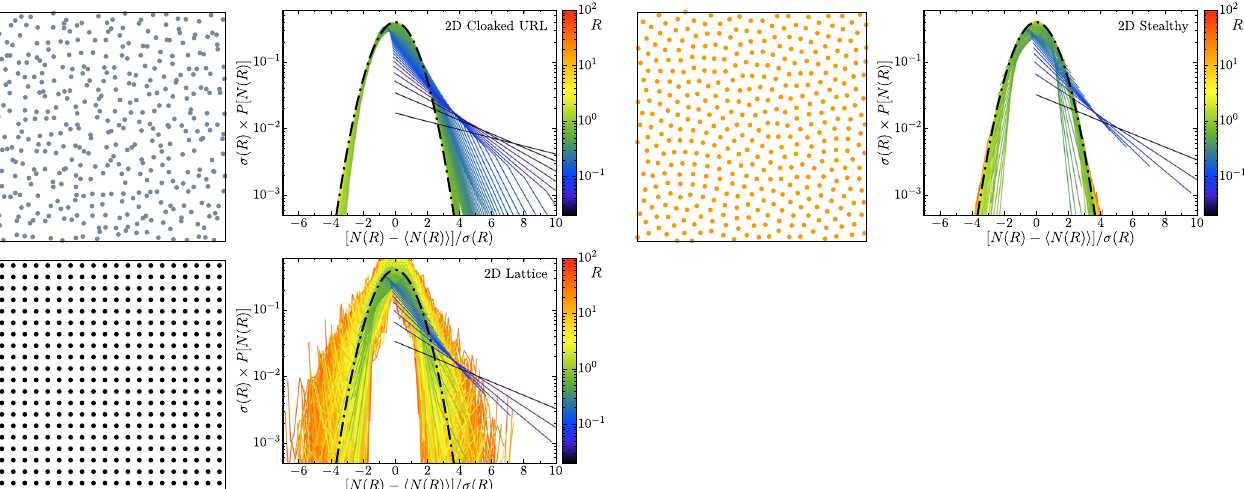
FIG. 4. Representative images of configurations of each of the three 2D hyperuniform models and their corresponding standardized probability distributions, where the deepest blue color (darkest shade) corresponds to zero radius and the deep orange color corresponds to the largest considered radius. The color code reveals differences between the results in this figure compared to the corresponding nonhyperuniform cases shown in Fig.